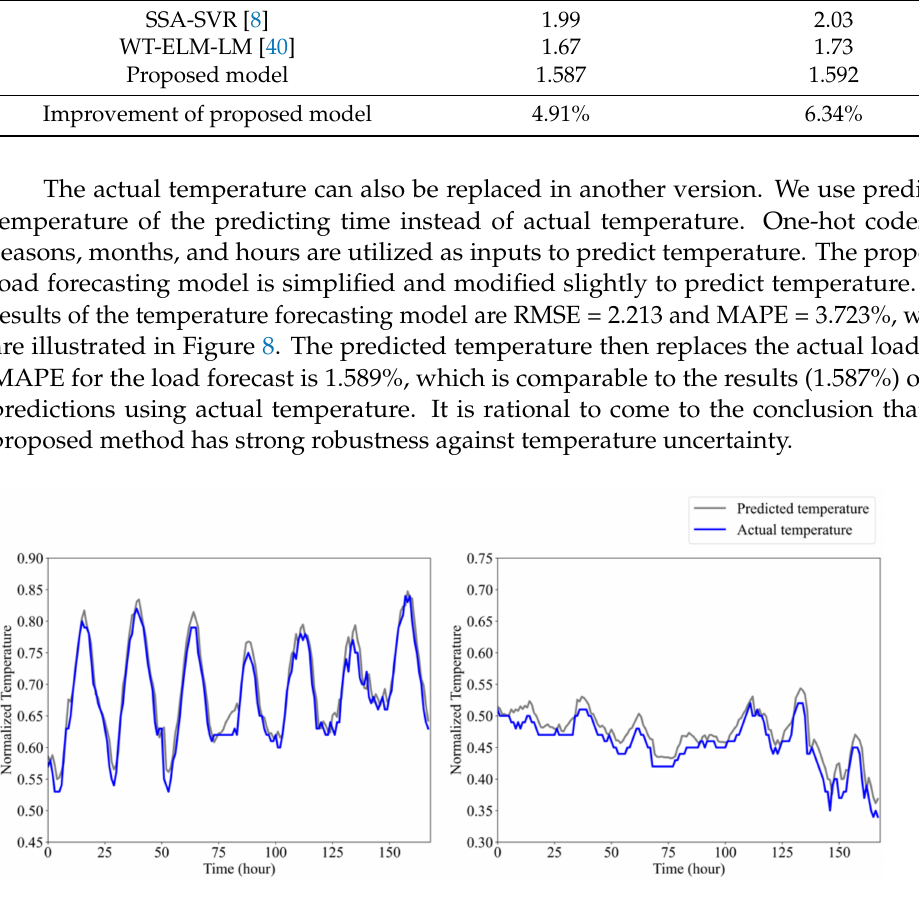
Figure 8. Actual and predicted temperature for a summer week ( left ) and a winter week ( right ) of 1991 for the North American Utility dataset; 1 August 1991 and 12 January 1991 begin the separate two-week